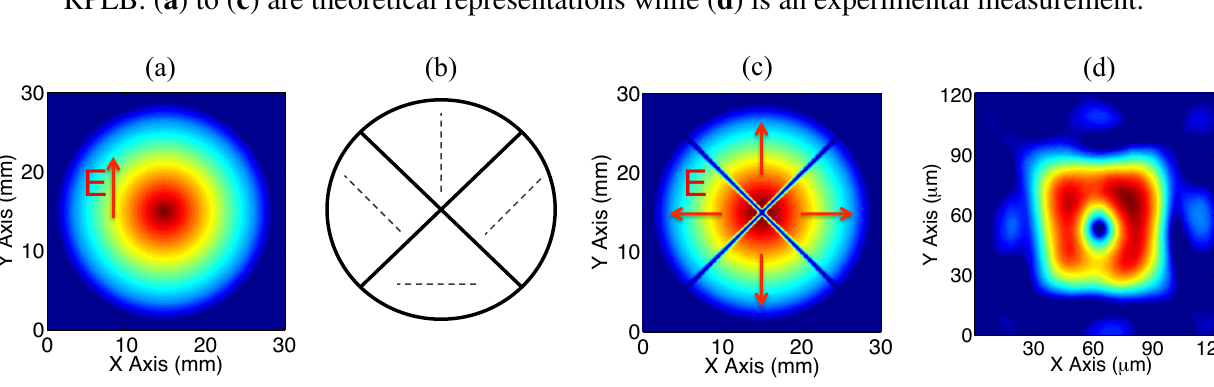
Figure 7. Method to generate the lowest-order RPLB. ( a ) Transverse profile of the incident linearly polarized Gaussian (TEM ) beam; ( b ) The polarization state converter (PSC) 00 composed of 4 sections of IR achromatic half-wave plates with the fast axis orientation of 0 ◦ (top), +45 ◦ (right), +90 ◦ (bottom), 45 ◦ (left); ( c ) The near field beam profile and relative − electric field direction at the output of the PSC; ( d ) The far field image of the weakly focused RPLB. ( a ) to ( c ) are theoretical representations while ( d ) is an experimental measurement.